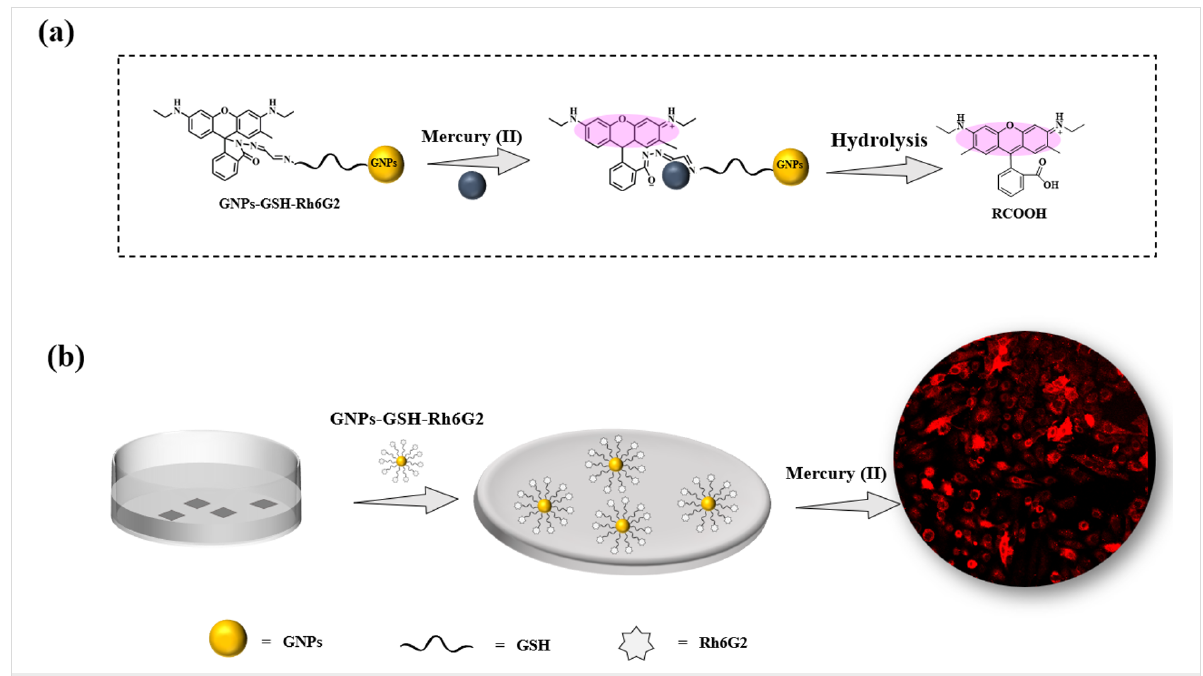
Figure 8: (a) Schematic illustration of the release mechanism of GNPs-GSH-Rh6G2 in the presence of Hg 2+ ; (b) release of RGCOOH in cells through Hg 2+ .